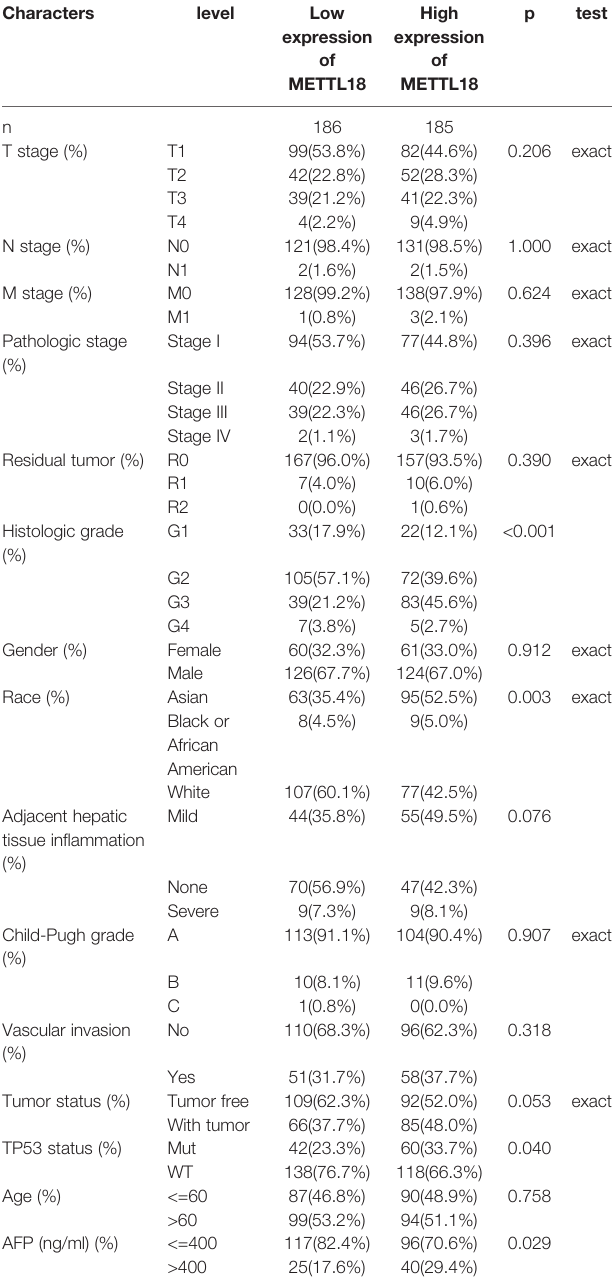
TABLE 1 | The correlation between clinicopathological variables and METTL18 expression.